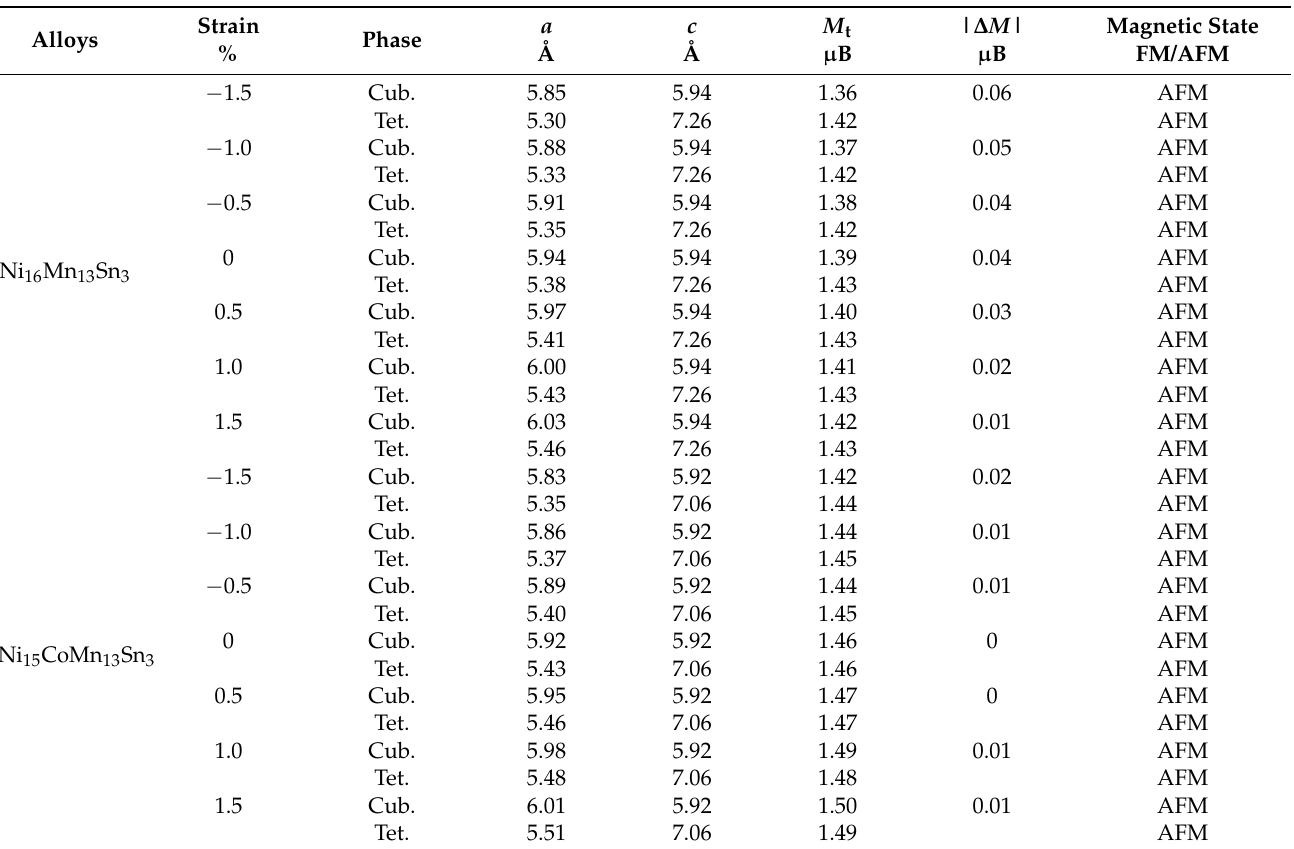
Table 1. Equilibrium lattice parameters, total spin moments and magnetic state of the cubic austenite (Cub.) and tetragonal non-modulated martensite (Tet.) for Ni 16 − x Co x Mn 13 Sn 3 ( x = 0, 1, 2) alloys with strain ( − 1.5~1.5%).